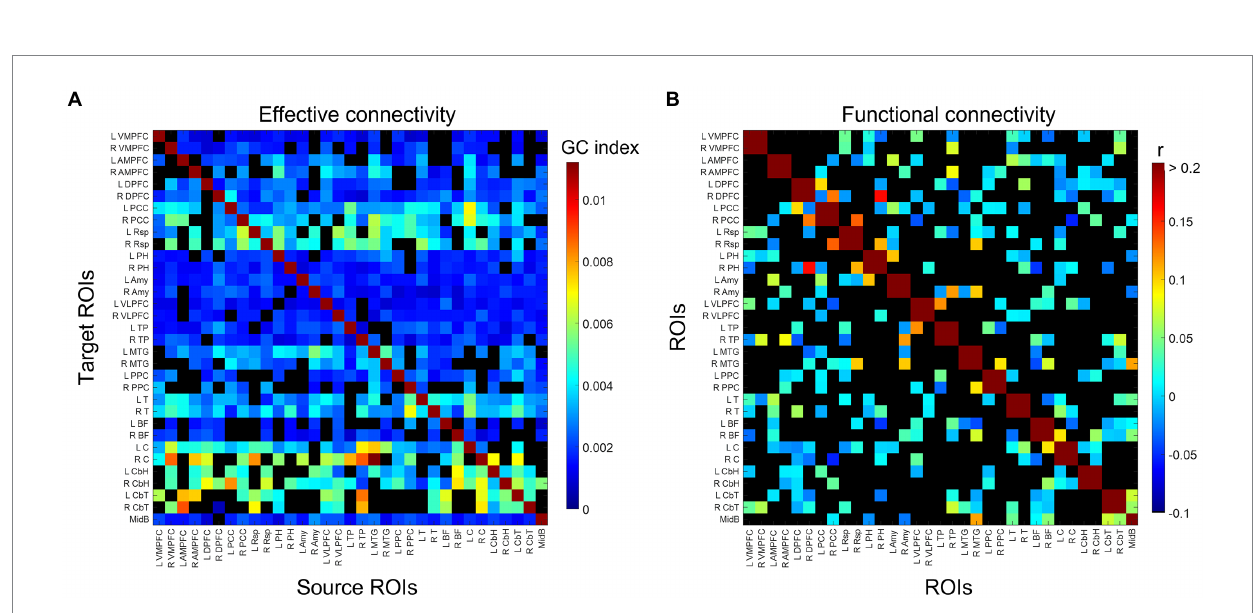
FIGURE 3 Identified group-consensus (A) EC (directed graph) and (B) FC (undirected graph) among 33 DMN ROIs for resting-state fMRI. The connectivity is shown in black if it is not statistically significant. VMPFC, ventro-median prefrontal cortex; AMPFC, antero-median prefrontal cortex; DPFC, dorsal prefrontal cortex; PCC, posterior cingulate cortex; Rsp, retrosplenial cortex; PH, parahippocampal region; Amy, amygdala; VLPFC, ventrolateral prefrontal cortex; TP, temporal pole; MTG, middle temporal gyrus; PPC, posterior parietal cortex; T, thalamus; BF, basal forebrain; C, caudate; CbH, cerebellar hemisphere; CbT, cerebellar tonsil; MidB, midbrain.